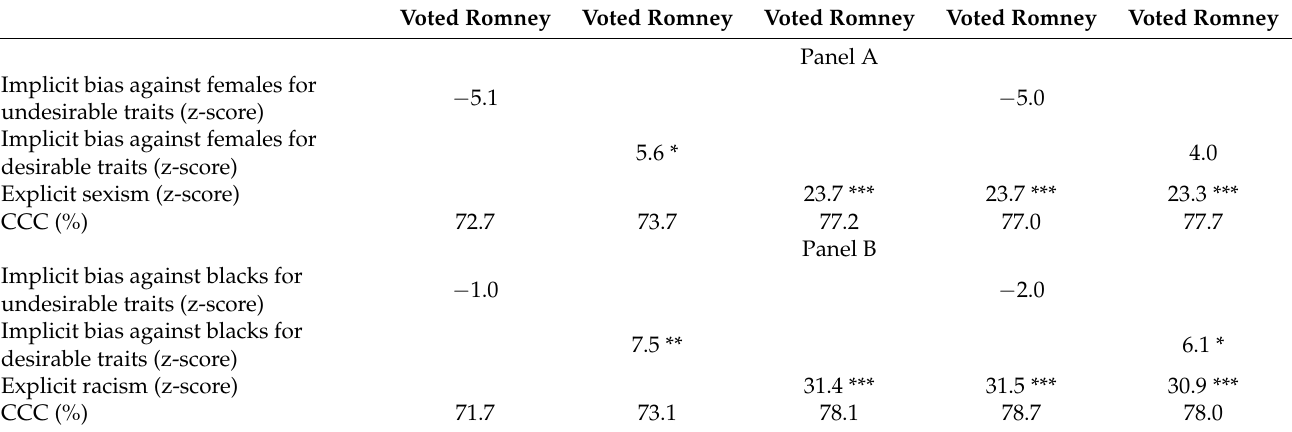
Table 4. Logit models comparing the effects of implicit bias and explicit prejudice on voting for Romney. Voted Romney Voted Romney Voted Romney Voted